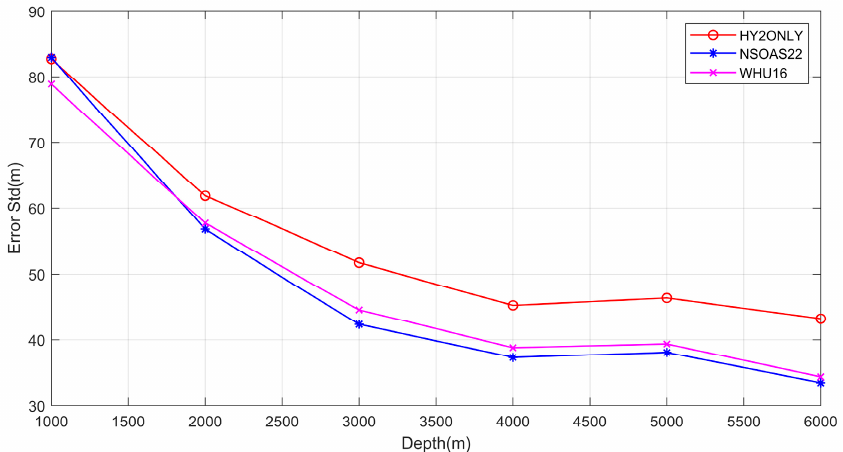
Figure 11. Variation of error STD with water